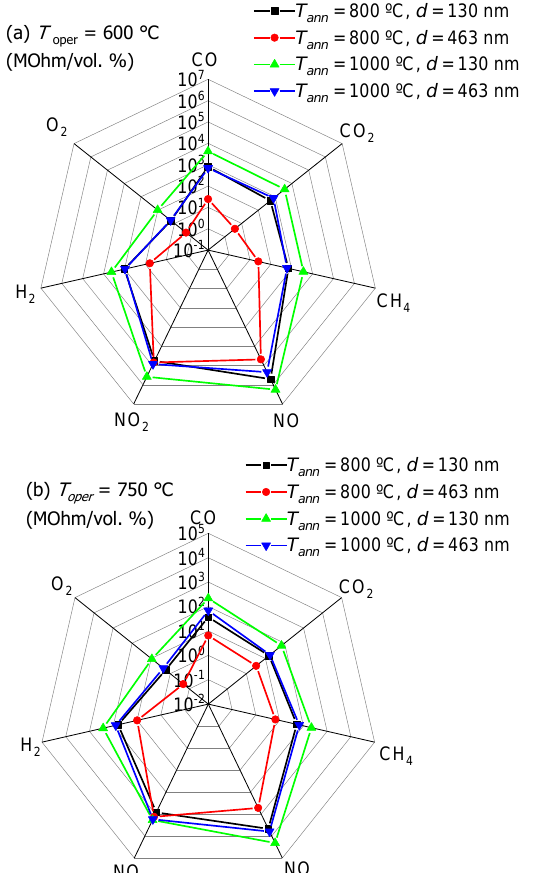
Figure 8. Sensitivity of TiO 2 thin films to various gases at T oper = 600 °C ( a ) and T oper = 750 °C ( b ).